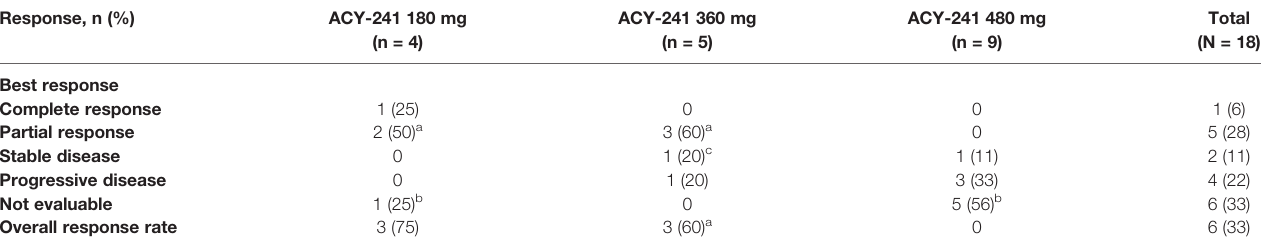
TABLE 3 | Best response per RECIST v1.1 (intent-to-treat population). Response, n